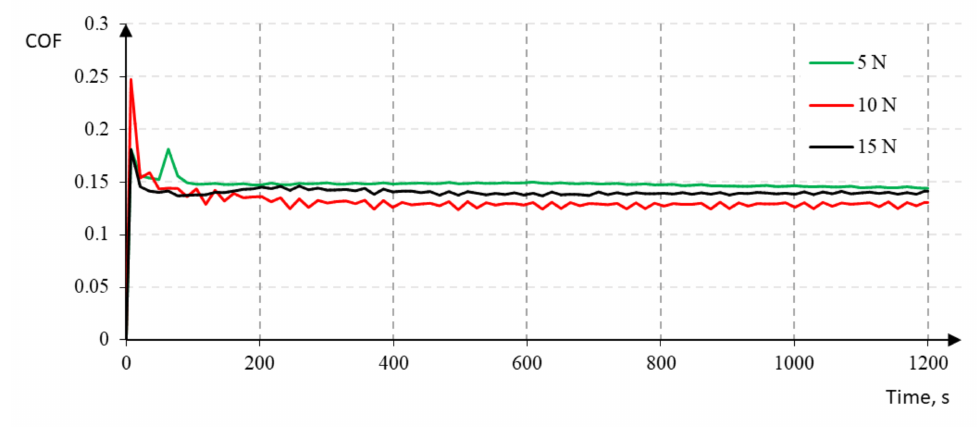
Figure 10. The friction coefficient measurements for Ni-P/Si 3 N 4 (2 g) sample with different ba- sic